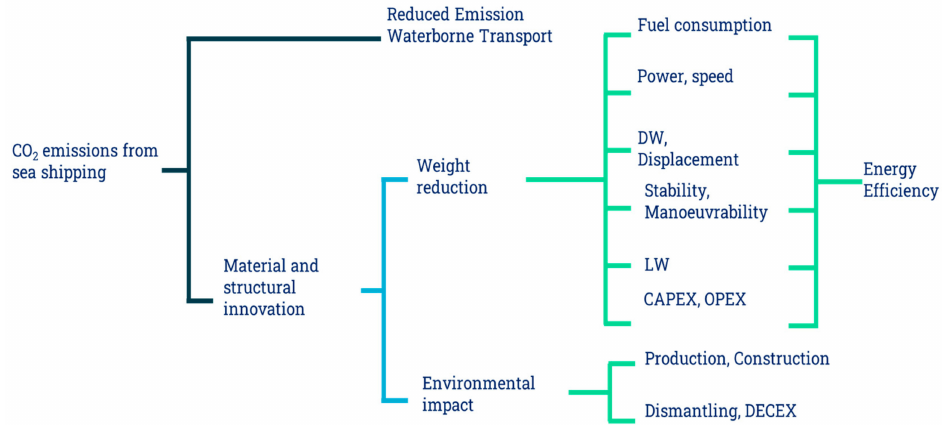
Figure 1. Key points to address to achieve environmental impact reduction in the shipping